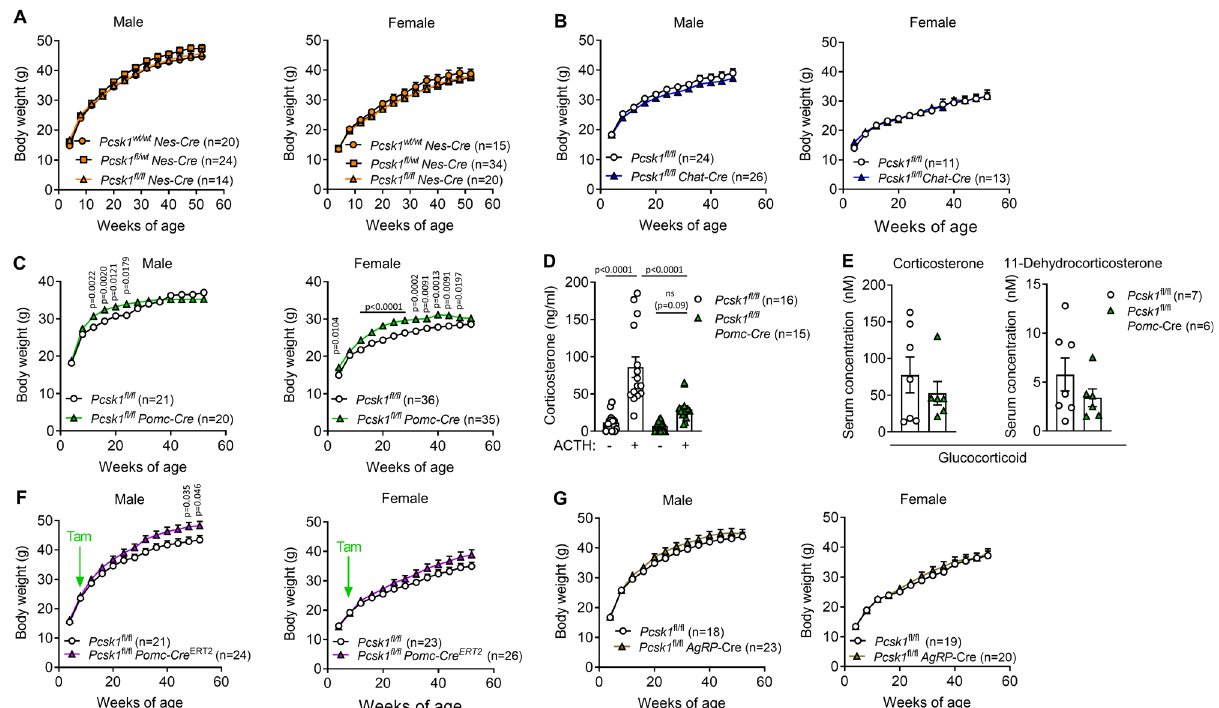
Fig. 2 | POMC-speci fi c PC1/3 ablation induces mild and transient overweight. A Bodyweightdevelopmentin Pcsk1 fl / fl Nes -Creandcontrollittermatemice. B Body weight development in Pcsk1 fl / fl Chat -Cre and control littermate mice. C Body weightdevelopmentin Pcsk1 fl / fl Pomc -Creandcontrollittermatemice. D Circulating corticosterone concentrations before and 1h after injection of 10 µ gkg − 1 human ACTH at 9:00 in female Pcsk1 fl / fl Pomc -Cre mice. E Circulating steroid concentra- tions at 11:00 in 12-week-old male Pcsk1 fl / fl Pomc -Cre mice. F Body weight devel- opment in Pcsk1 fl / fl Pomc -Cre ERT2 and control littermate mice. G Body weight